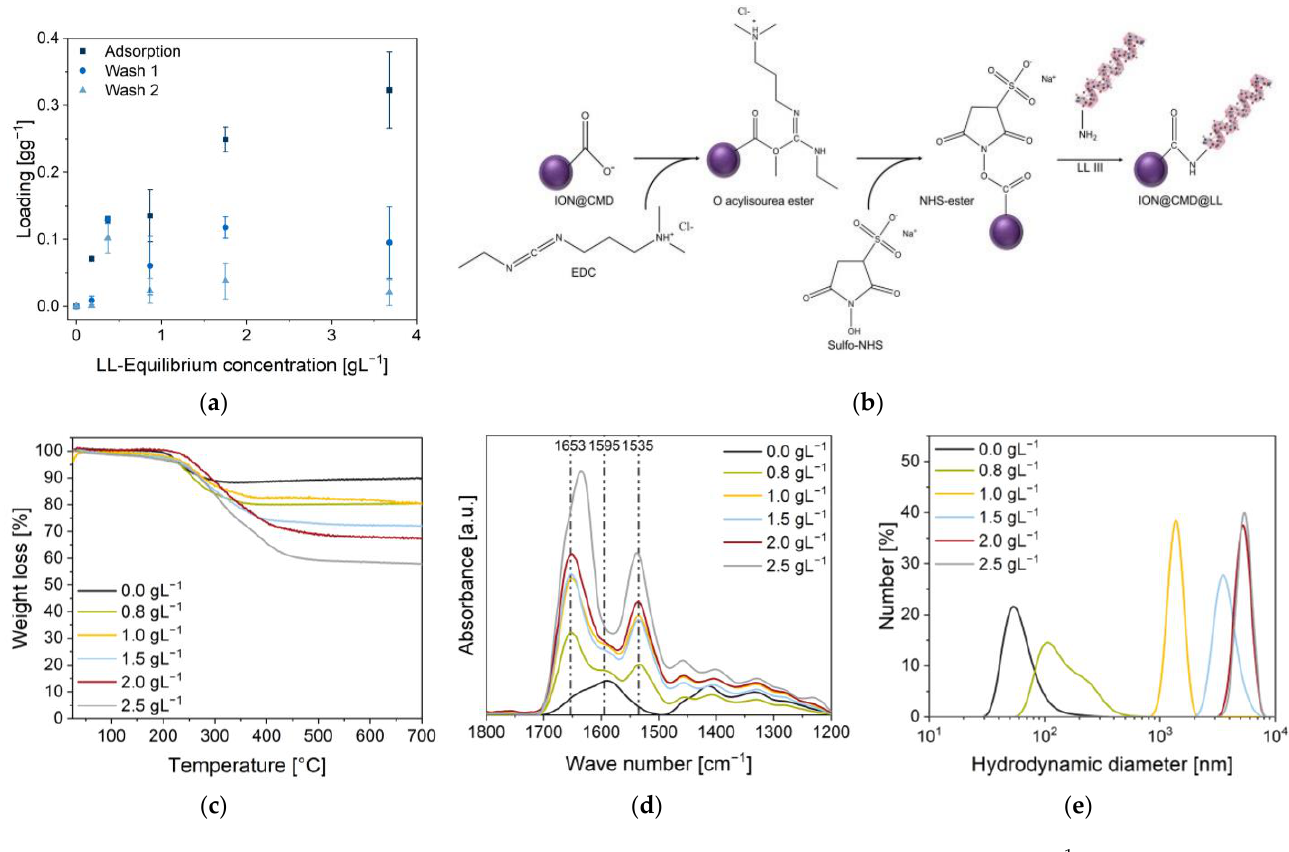
Figure 6. ( a ) Adsorptions of LL at pH 7.4 in 50 mM of PBS buffer and 1 g L −1 of ION@CMD12.5. Covalent binding of cationic peptide LL (0.0 g L −1 – 2.5 g L −1 input) to the surface of the ION@CMD12.5 particles. ( b ) EDC reacted with the free carboxyl group of CMD to form an unstable O-acylisourea ester intermediate. Sulfo-NHS was added to the reaction to form a more stable NHS ester, which reacts slowly with primary amines of LL to form stable amid bonds. LL was created with BioRender.com. ( c ) TGA measurements until 700 °C. ( d ) FT-IR spectra of the ION@CMD and ION@CMD@LL particles (24 scans) with labeled characteristic LL bands at 1653 cm −1 and 1535 cm −1 and the characteristic CMD band at 1595 cm −1 . ( e ) Hydrodynamic diameters of the unloaded (ION@CMD) and loaded particles in an aqueous medium (pH = 7 – 8). Table 2. Loadings achieved by covalently bound LL. Drug loadings were calculated from the photometric and TGA data. Zeta potential sand DLS measurements were performed in Millipore ® H 2 O at a pH between 7 and